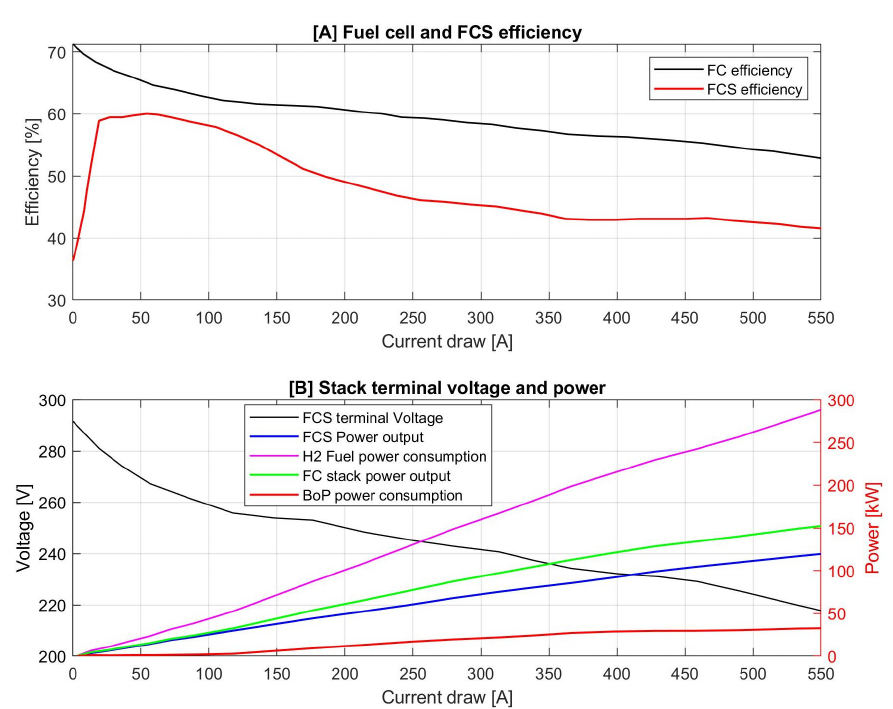
Figure 9. ( A ) Fuel cell stack and fuel cell system energy conversion efficiencies based on current draw inspired from Toyota Mirai 2 bench-marking tests performed by AVL and FEV, ( B ) corresponding stack terminal voltage drop and FCS, FC stack, BoP components, H 2 fuel power